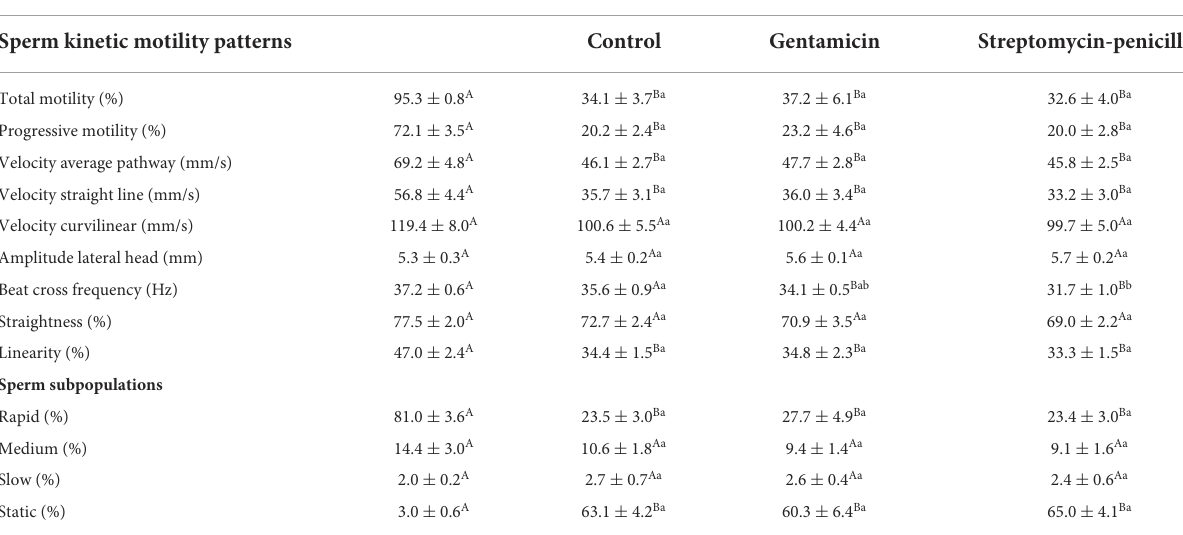
TABLE 1 Mean ( ± SEM) values for kinetic motility patterns in fresh and frozen-thawed semen from collared peccary ( n = 10) supplemented or not with different antibiotics (gentamicin and streptomycin-penicillin combination).